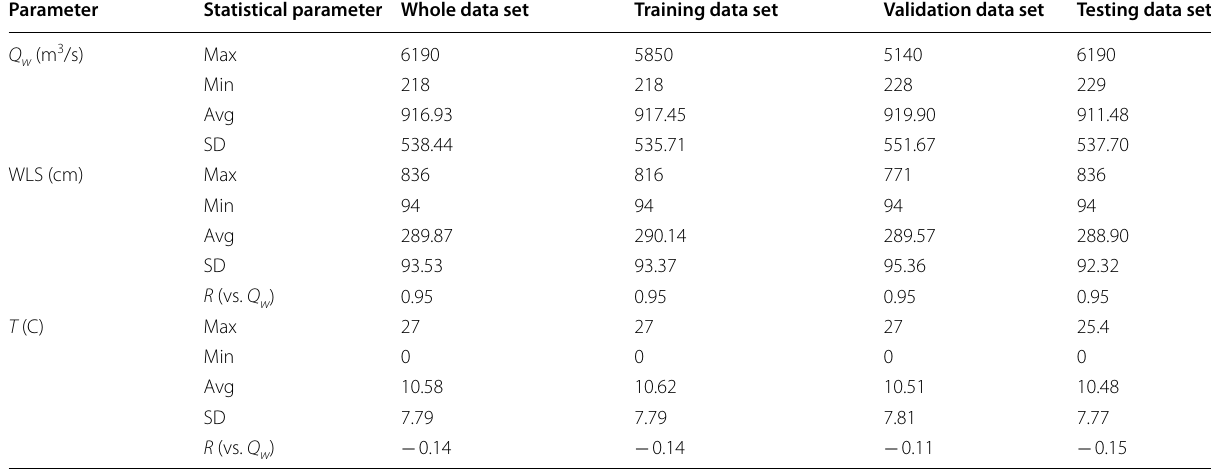
Table 3 Statistical characteristics of used data sets